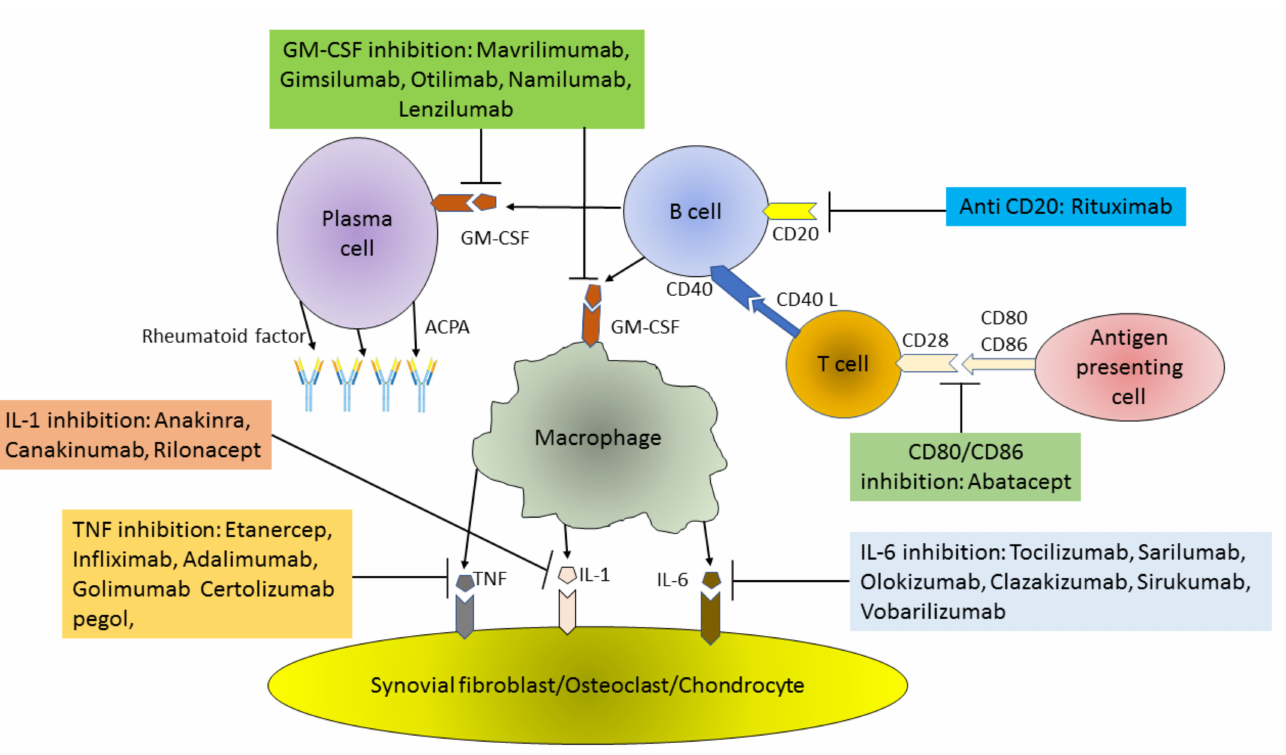
Figure 1. Pathogenesis of RA (Rheumatoid arthritis) and main targets of biological therapy. ACPA – Anti CCP Ab: Anti- Citrullinated Protein Antibodies; GM-CSF: Granulocyte-Macrophage Colony Stimulating Factor; TNF: Tumor Necrosis Factor; IL: